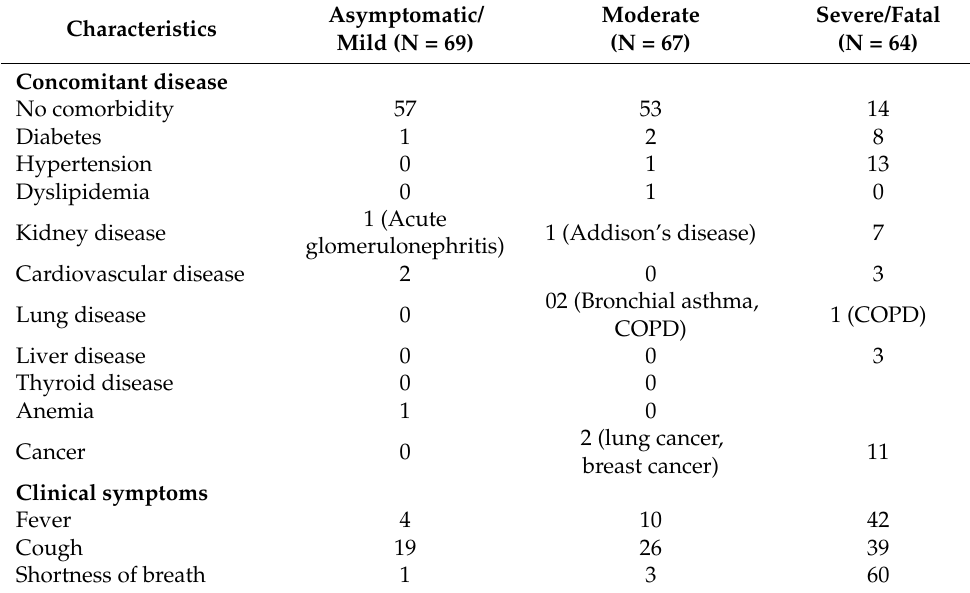
N: Number of subjects; COPD: Chronic Obstructive Pulmonary